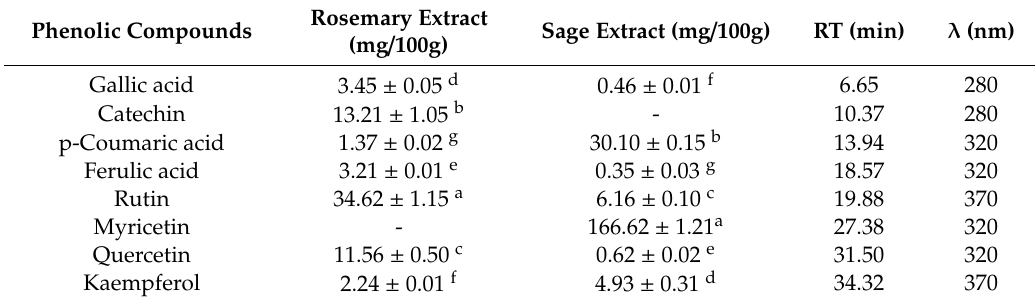
Table 2. Content of phenolic compounds by HPLC of rosemary and sage